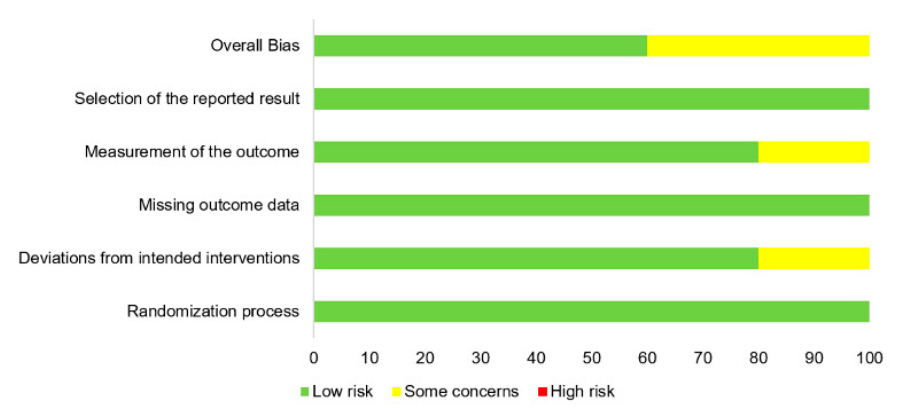
Figure 2. Quality assessment of the five randomized clinical trials.